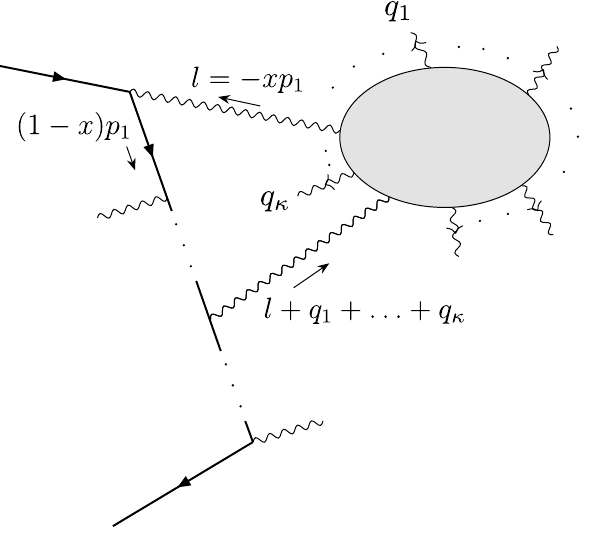
Figure 8. The class of diagrams that contributes to the M (2) cient.